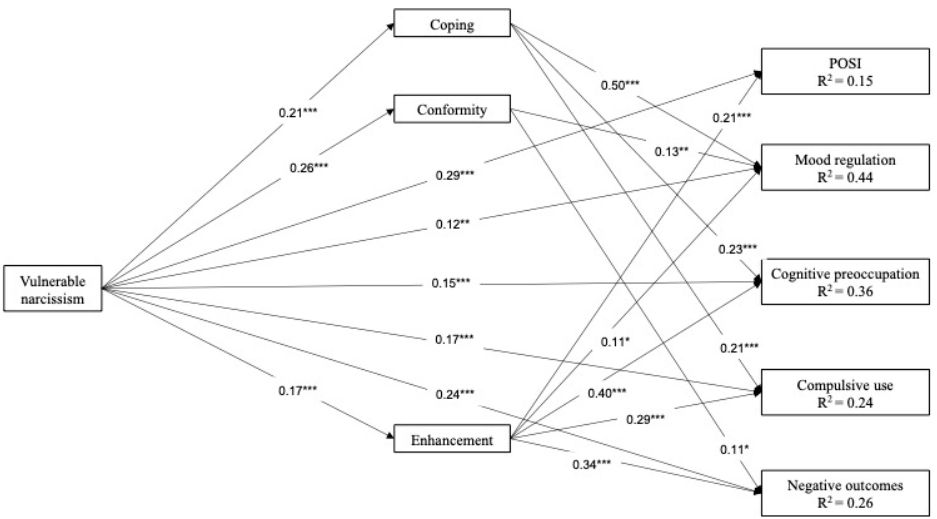
Figure 1. Mediation model with standardized effects. Note. Intercorrelations among mediator and